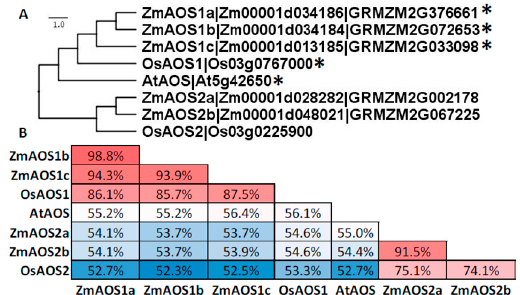
Figure 6. Amino acid sequences of CYP74A family members from Arabidopsis , maize, and rice compared with ClustalX and visualized with Figtree. ( A ) Gene labels follow nomenclature for maize (this chapter) and rice [72]. * denotes predicted CTP by ChloroP. ( B ) Identity analyses was performed with SIAS. The color code (red to white to blue) scale represents the percent sequence identity from greatest to least.